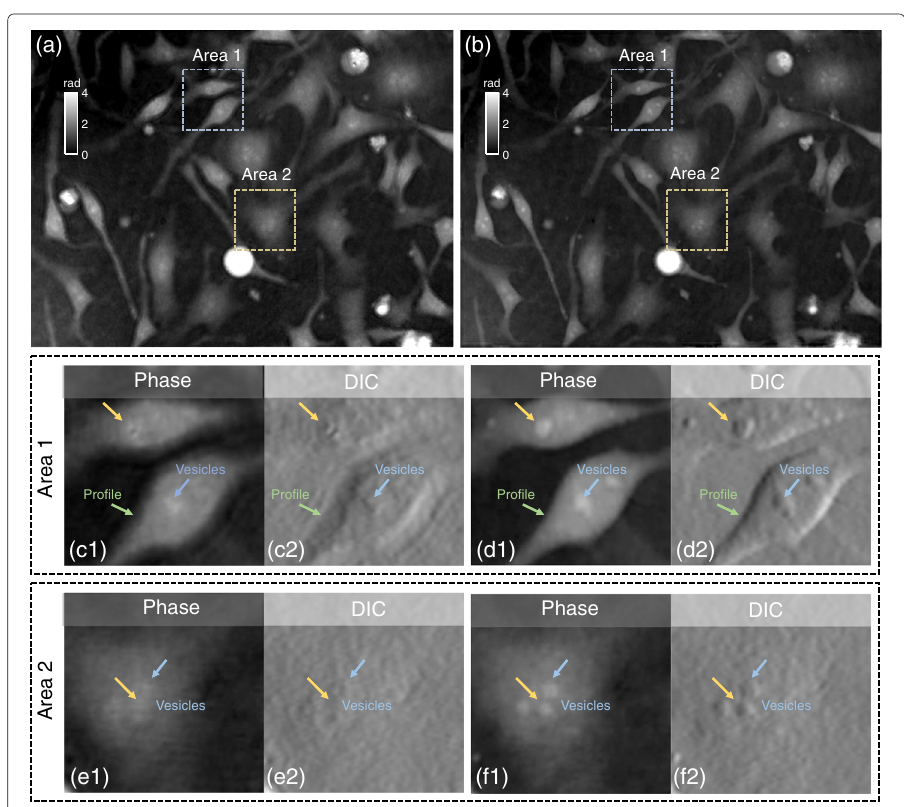
Fig. 8 Comparison of reconstructed phase without and with correcting defocus aberration. (a) Reconstructed phase without correcting defocus aberration. (b) Reconstructed phase with correcting defocus aberration. (c1), (e1) Selected enlarged regions of interest of (a) [without correcting defocus aberration]. (c2), (e2) Digital DIC results corresponding to quantitative phase in (c1), (e1) [without correcting defocus aberration]. (d1), (f1) Selected enlarged regions of interest of (b) [with correcting defocus aberration]. (d2), (f2) Digital DIC results corresponding to quantitative phase in (d1), (f1) [with correcting defocus